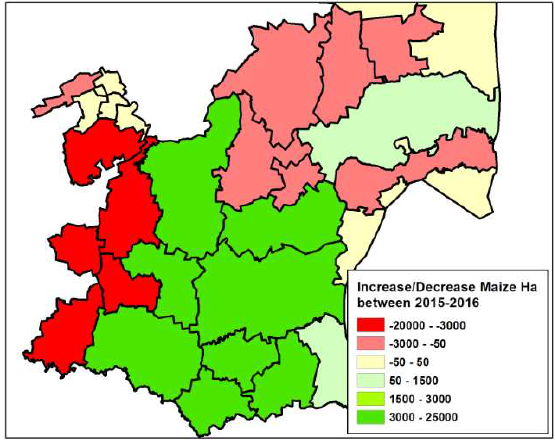
Figure 16. Calculated increase or decrease in area (Ha) of maize cultivated in 2014 and 2015 in Mpumalanga